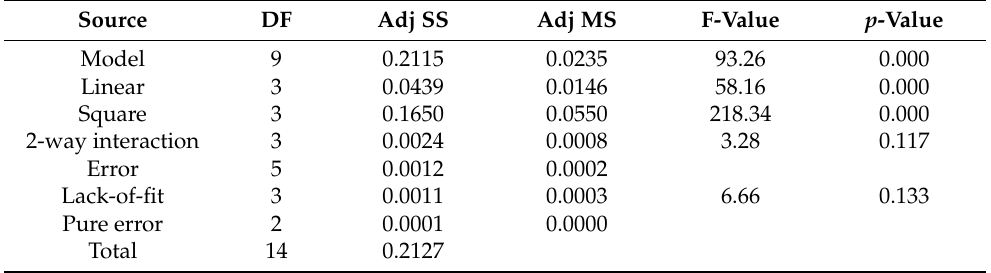
Table 5. ANOVA for SR in